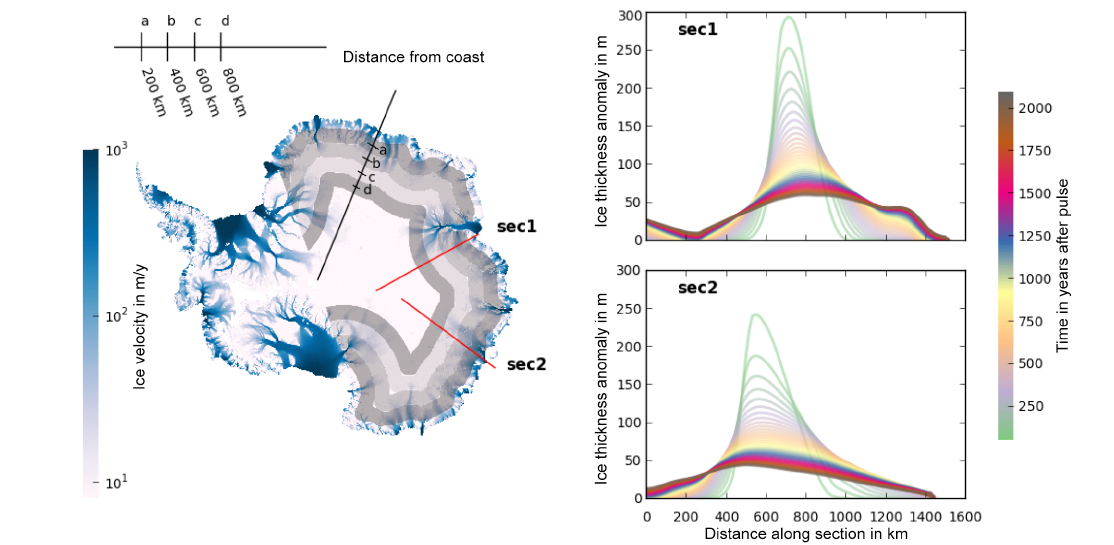
Figure 1. Bands of ice mass addition in East Antarctica and ice thickness relaxation for the 800km band. Left panel: surface velocities of the ice flow of the Antarctic ice sheet (blue shading). Grey strips indicate where ice mass was added to East Antarctica in order to delay future sea-level rise in the different simulations. The ice was added in strips of 200km width for 100 years. The right panels show the ice thickness relaxation after the end of the mass addition to the 800km band in time steps of 50 years for two representative sections (left panel, red lines) as an anomaly to the equilibrium